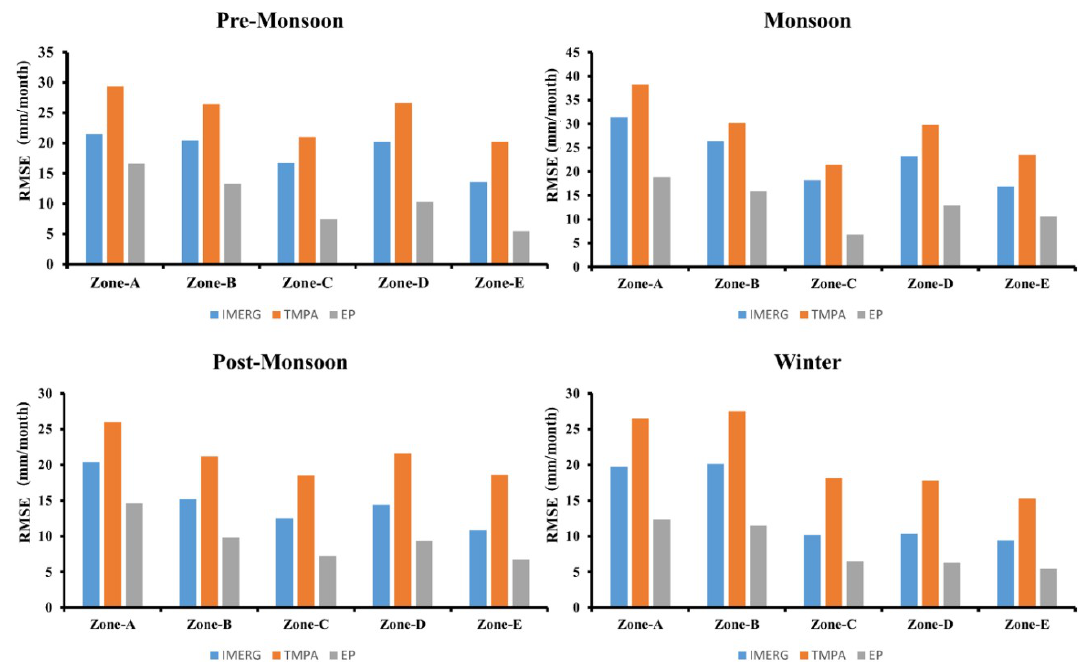
Figure 6. Root mean square error (RMSE) of satellite products and EP algorithm during the pre-monsoon, monsoon, post-monsoon, and winter seasons.